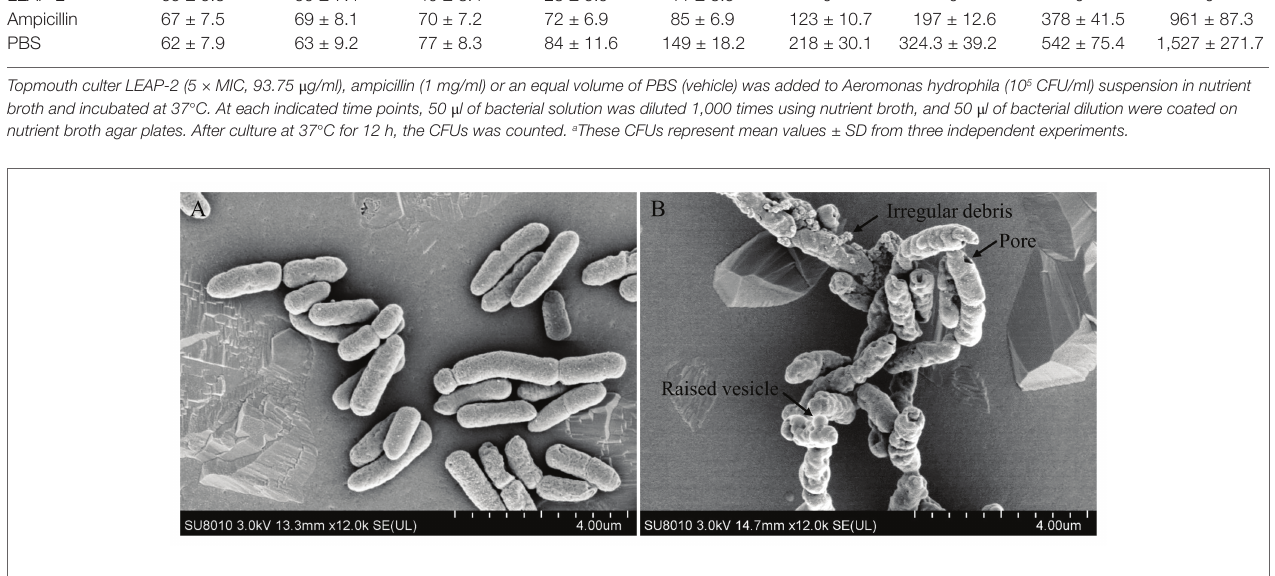
FIGURE 4 | Effects of topmouth culter LEAP-2 on the surface morphology of A. hydrophila. A. hydrophila (about 5 × 10 6 CFU/ml) were incubated with PBS (vehicle; A ) or topmouth culterLEAP-2 (5 × MIC; B ) at 37 °C for 30 min. The surface morphology was observed with a Hitachi SU8010 scanning electron microscope. The typical alterations that formed on bacterial surface, including raised vesicle, irregular debris, and pore, were marked with arrows as indicated in B